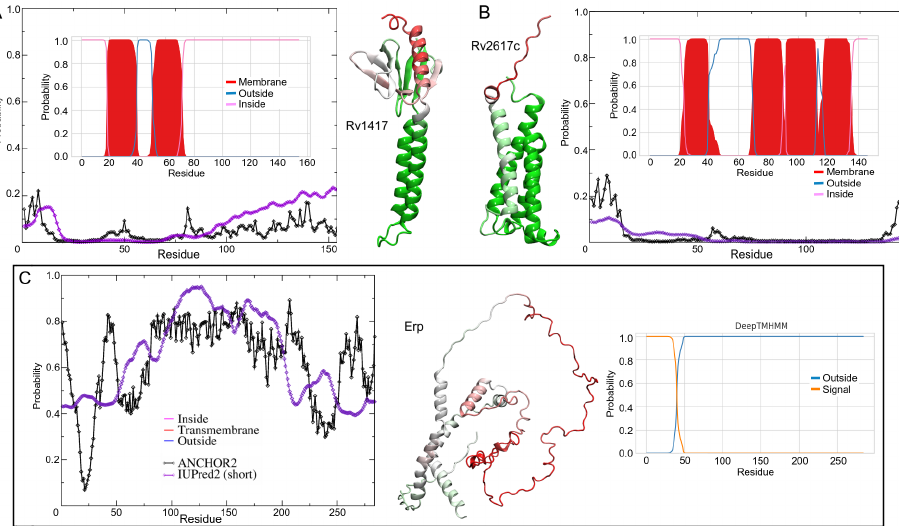
Figure 1. Prediction of transmembrane helices and disordered protein regions of the Mtb proteins studied. The inner plots show the probability of residue forming helical structures. The probability was calculated based on a deep learning protein language model-based algorithm. The filled curves (red color) are the helical residues, while blue and magenta lines mean the inside or outside membrane regions, respectively. The disorder regions (outer plots) were analyzed by IUPred2 (purple line) and ANCHOR2 (black line) algorithms. For a better representation, the disorder probability values were mapped on the 3D structures. Red, white, and green colors represent high, mean, and low probabilities of disordered conformation, respectively. ( A ) Rv1417, ( B ) Rv2617c, and ( C )